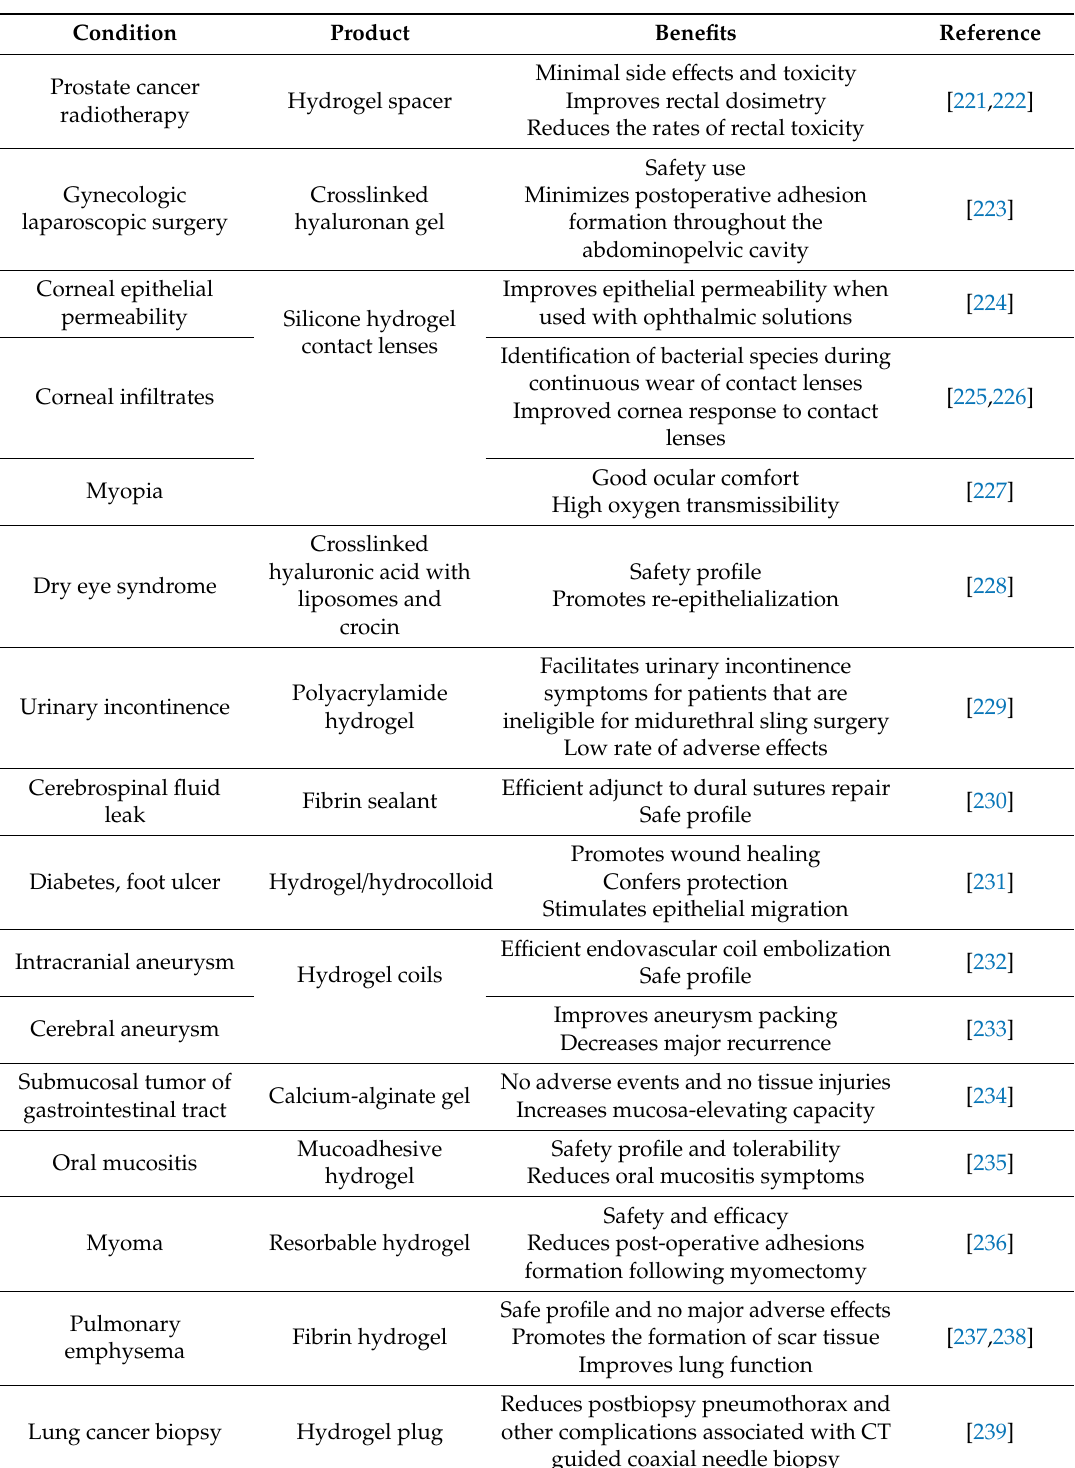
Table 2. Di ff erent completed clinical trials using hydrogel based products